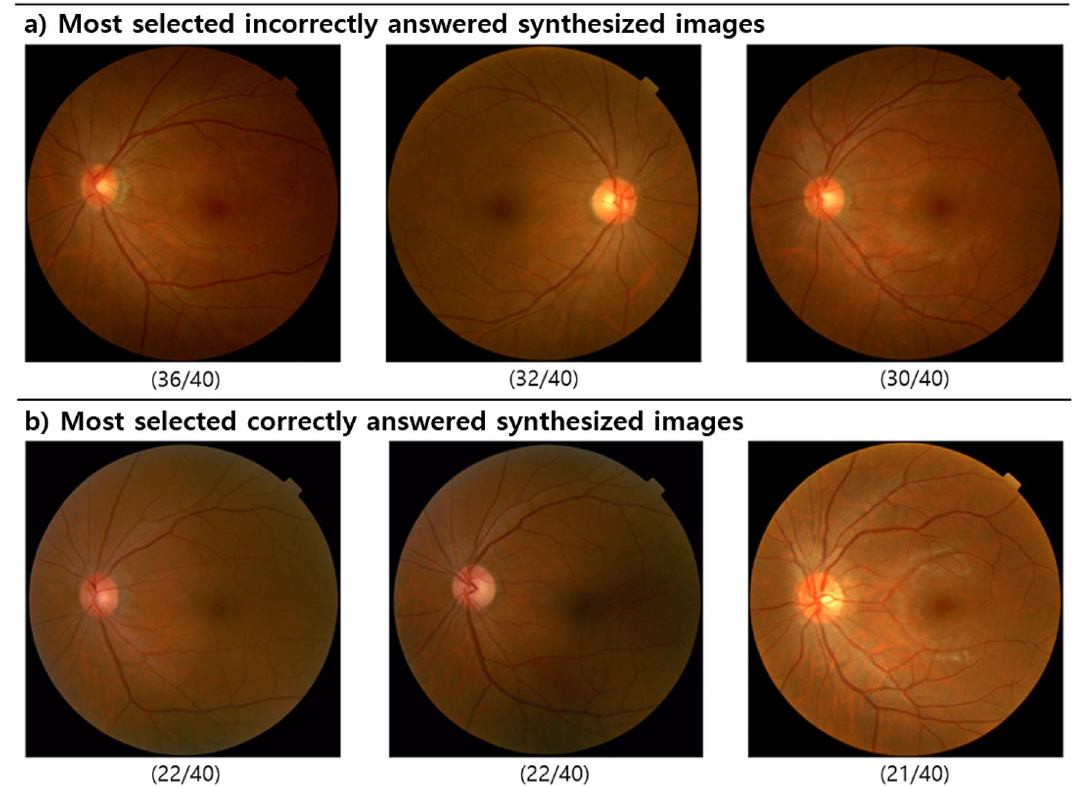
Figure 2. High-resolution synthesized retinal photographs. ( a ) Synthesized retinal images that most ophthalmologists selected as “real” image. ( b ) Synthesized retinal images that most ophthalmologists considered as “synthesized” images. Numbers in parentheses indicate the number of examiners out of 40 ophthalmologists who chose image as “real” or